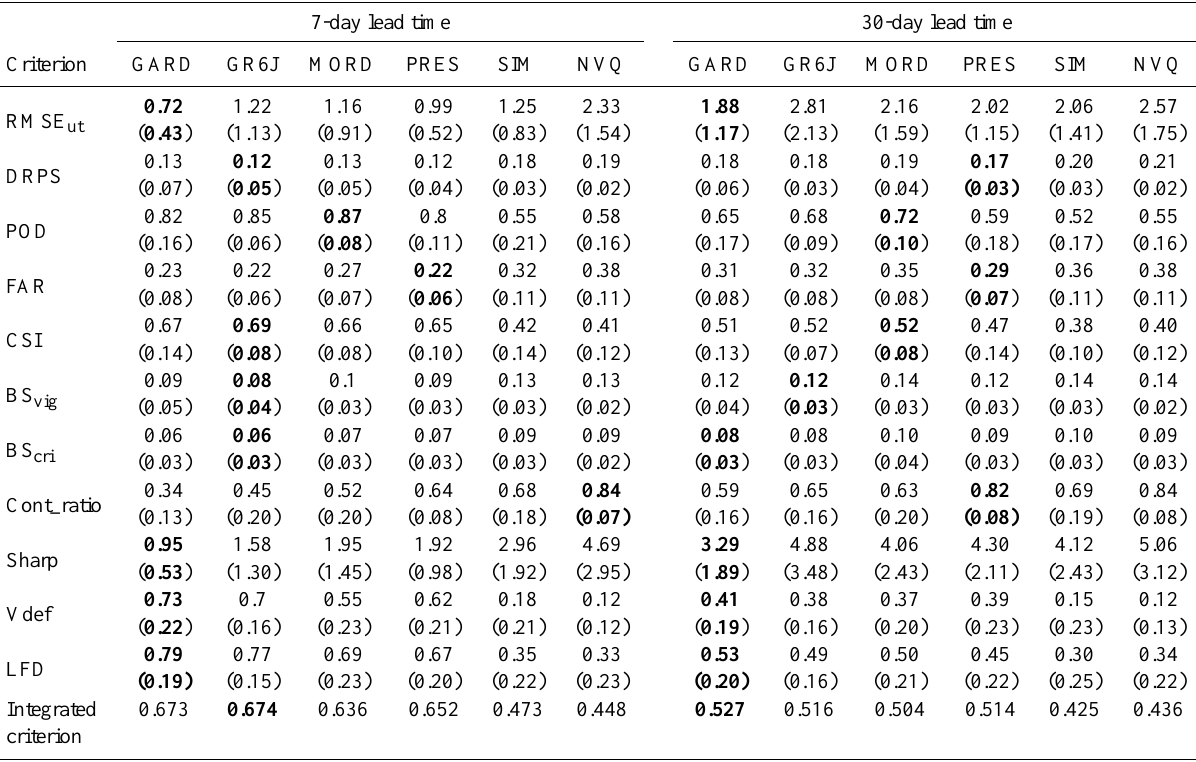
Table 7. Models’ mean performances (with standard deviation in brackets) on the 21 catchments for validation period 2 and for the two selected forecasting lead times. Bold values indicate the best